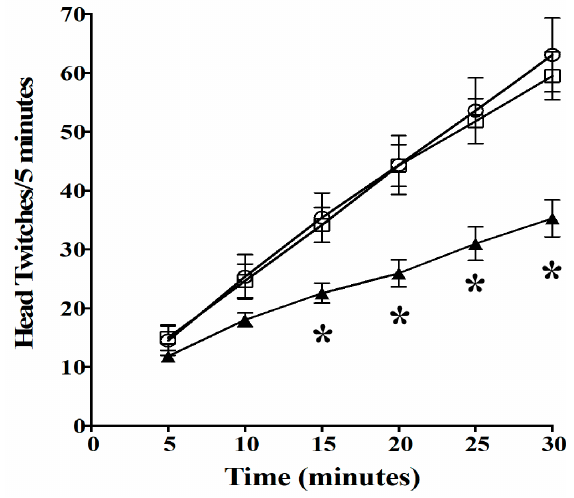
Figure 4. Inhibition of the Murine DOI-Dependent Head Twitch Response by Compound 6a. The inhibition of the DOI-dependent Head Twitch Response (HTR) by compound 6a as a function of time (minutes) is shown. Male DBA/2J mice were dosed with 5 mg/kg of DOI in the presence of 10 mg/kg of compound 6a . The vehicle control studies were performed either one week before (– □ –), or one week after (– ○ –) the compound 6a (– ▲ –) was evaluated. The data shown is the mean num- ber of head twitches ± S.E.M. averaged by two observers cumulatively at 5 min. Intervals for n = 7 mice. * A p < 0.05 was observed compared to both controls at times 15–30 min (one-way ANOVAs revealed main effects of Groups (F 2,18 ranging from 5.1 to 10.4 with p < 0.019) and were followed by post-hoc analyses).